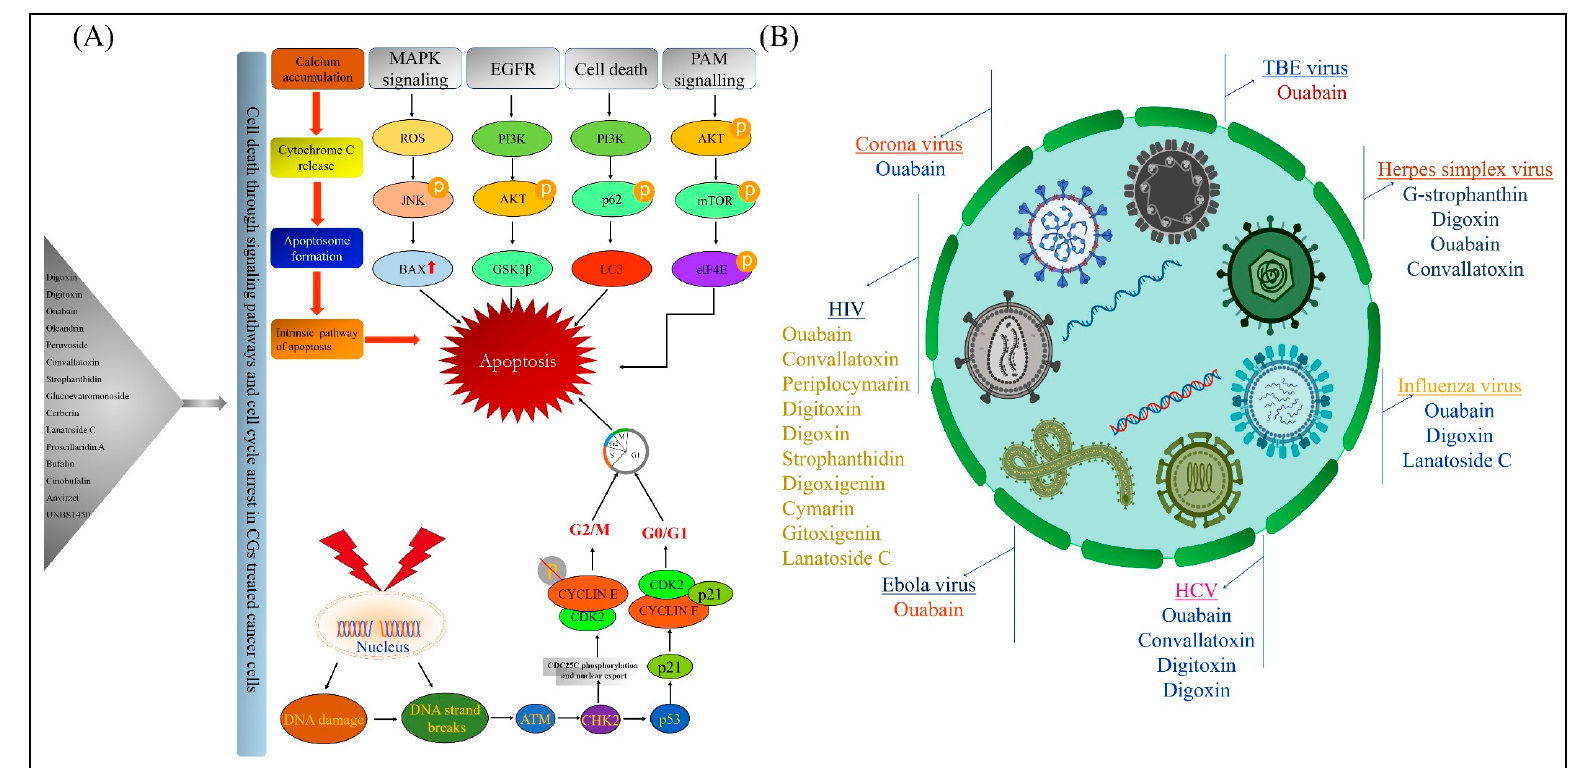
Figure 1. Schematic representation of anticancer and antiviral activities of cardiac glycosides. (A) Possible mechanism in human cancers (EGFR—epidermal growth factor receptor; eIF4E—eukaryotic translation initiation factor 4E; PAM—PI3K/AKT/mTOR; PI3K—phosphatidylinositol 3-kinase; mTOR—mechanistic target of rapamycin); (B) illustration of potent antiviral diseases (HCV—human cytomegalovirus; HIV—human immunodeficiency virus; HSV—herpes simplex virus; TBE—tick-borne encephalitis virus).